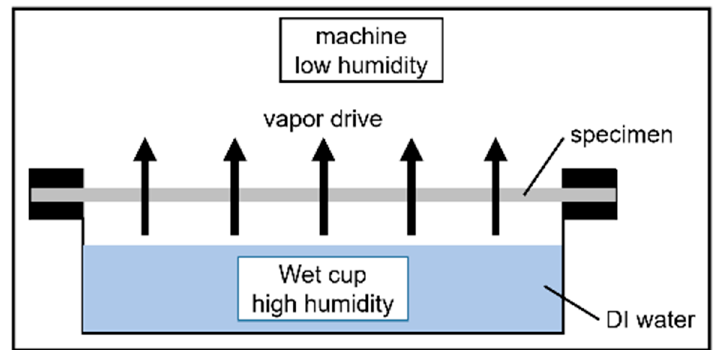
Figure 3. ASTM E96/E96M-16 upright cup and the wet cup method.